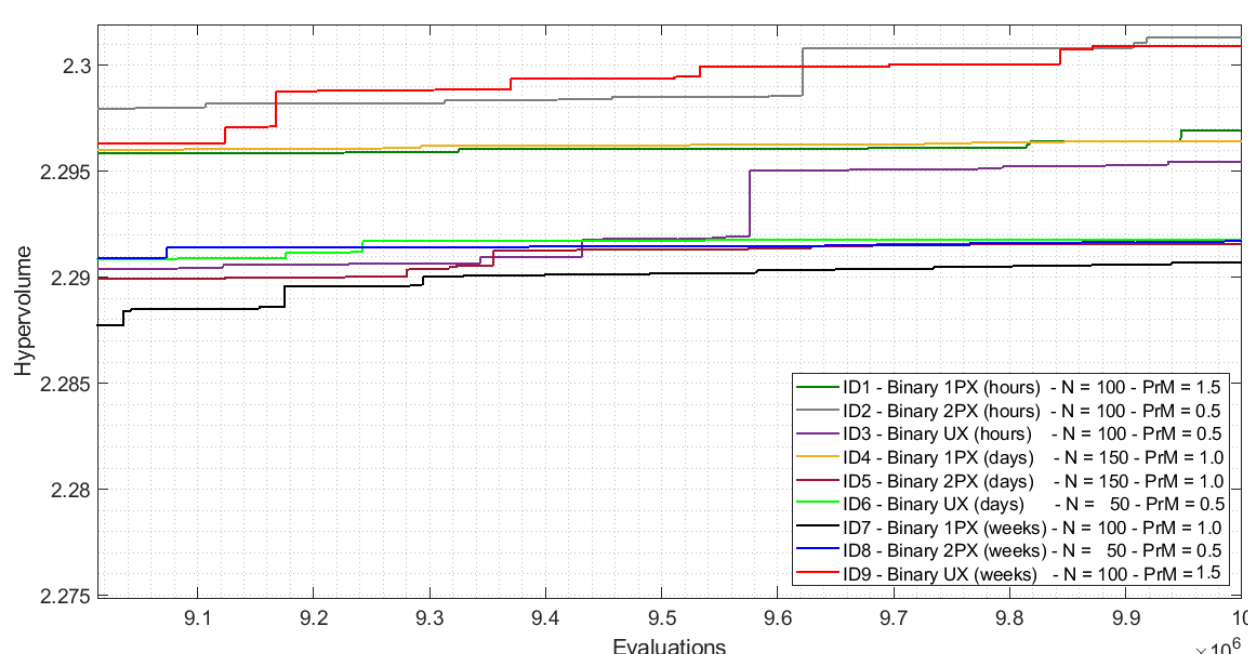
Figure 4. Hypervolume Average vs. evaluations (accuracy experiment). Box plots of the Hypervolume values distribution at the end of the process are shown in Figure 5. They are ordered from left to right in relation to time units of hours (H), days (D) and weeks (W) and crossover types of one point (1PX), two point (2PX) and uniform crossover (UX). It can be seen that the medians are ordered from biggest to smallest for each group of crossover. The greater the accuracy the bigger the Hypervolume median value (it is greater for hours than for days and greater for days than for weeks). Statistical information in relation to the Hypervolume value at the end of the evolutionary process is shown